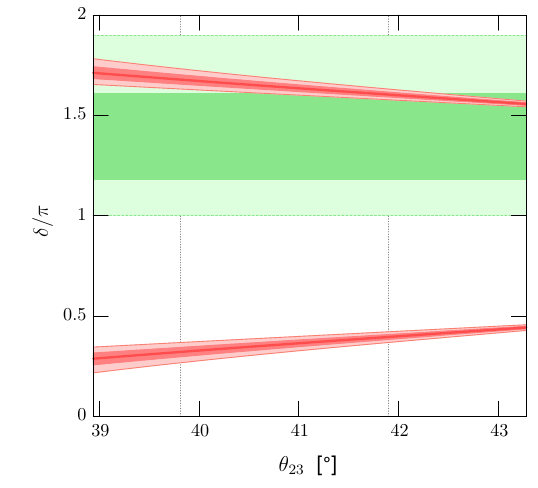
Fig. 2 The prediction for the Dirac CP phase δ in the minimal gauged U ( 1 ) L μ − L τ model. The red lines show the CP phase δ against θ 23 . θ 23 is varied in the 2 σ range, and the 1 σ range is in between the vertical thin dotted lines. The dark (light) red bands show the uncertainty coming from the 1 σ (2 σ ) errors in the parameters θ 12 , θ 13 , δ m 2 , and (cid:6) m 2 . We also show the 1 σ (2 σ ) favored region of δ in the dark (light) horizontal green